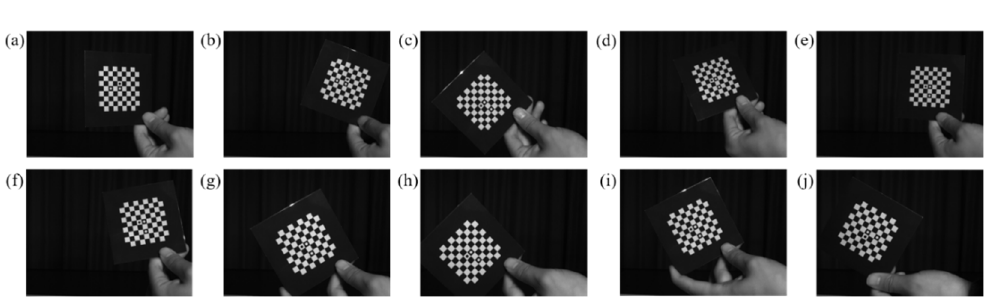
Figure 11. Calibration images ( a – j ) captured in different pose.